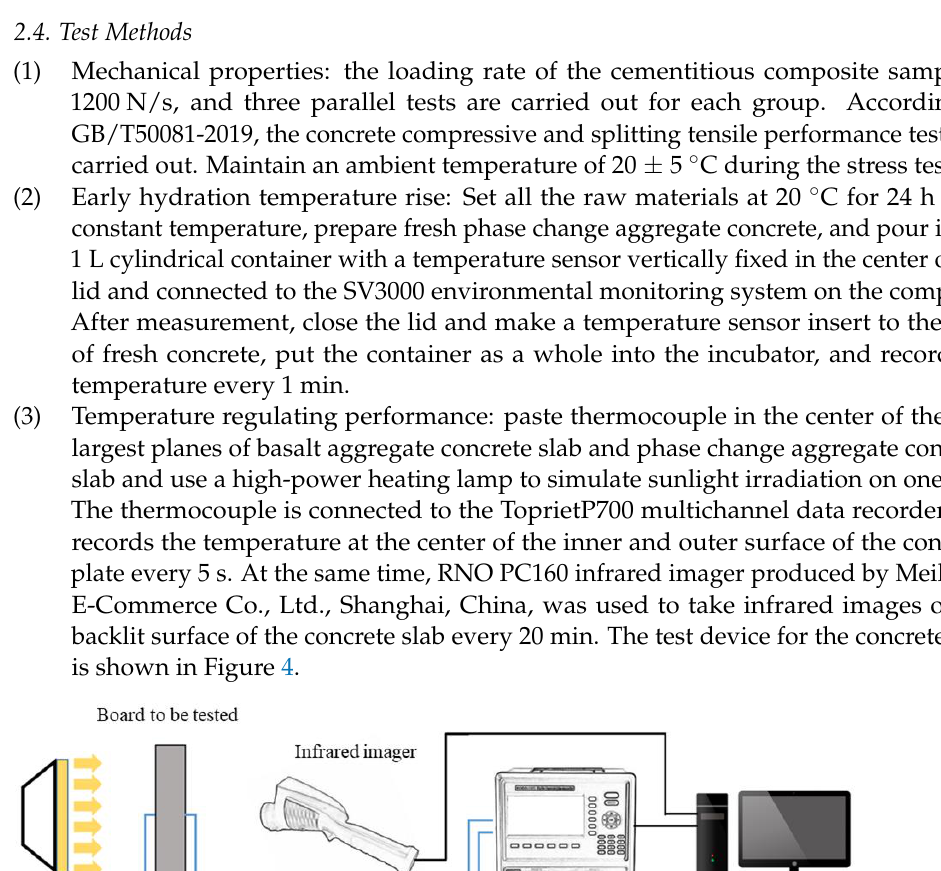
Figure 5. Test system for the thermal insulation performance of cube model. 3. Results and Discussions 3.1. Compressive Mechanical Properties The effects of aggregate type and paraffin filling on the compressive property of the phase change cementitious composite sample are shown in Figure 6. All curves are sharp, with a linear elastic rising stage, then rapidly dropping when it reaches failure, showing brittleness characteristics. The shapes of several curves are similar, indicating that differ- ent aggregate types and properties have little change in the failure process. It can be seen from the stress – strain curve that, compared with pure mortar M − 0, the compressive strength of phase change cementitious composite containing aggregate decreases, whether basalt aggregate or phase change aggregate is added. It is important to consider the effect of the mass per unit volume of the sample on the strength. the 3D printed ag- gregate inside sample M − PCM0 was not filled with PCM and sample M − PCM99 was filled with PCM. By weighing the samples, it was found that the difference in weight between the two was very small, as the density of the filled PCM was very low. Such a difference in mass is negligible in relation to the total mass of the sample. Adding a small amount of aggregate to the cementitious composite and not accumulating dense, the limited amount of aggregate will not only fail to form the skeleton structure but also destroy the homoge- neity of the mortar system and introduce a relatively weak interface. Therefore, adding a small amount of aggregate will lead to the decline of compressive strength.